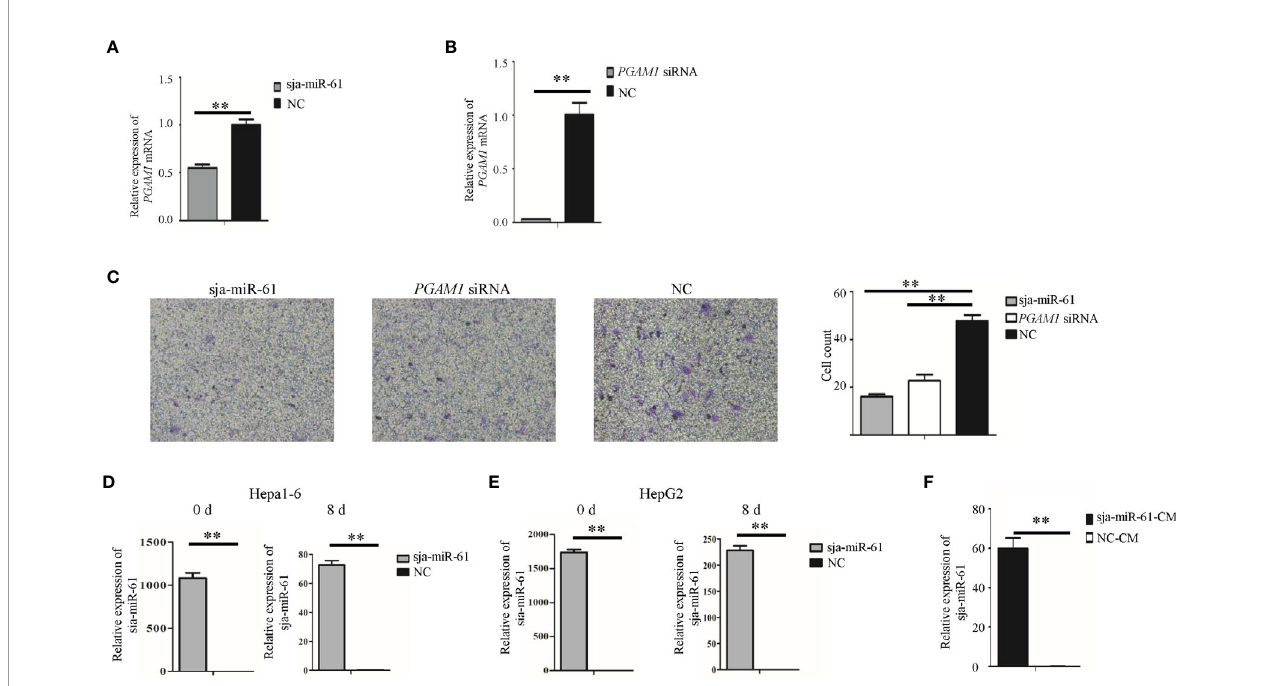
FIGURE 7 | Sja-miR-61-mediated inhibition of migration and tube formation of HUVEC cells by down-regulating PGAM1 in vitro . (A, B) HUVEC cells were transfected with sja-miR-61 mimics and NC mimics (A) , PGAM1 siRNA and NC siRNA (B) , respectively, and 48 h later, the expression of PGAM1 was determined using qRT-PCR. Cell migration was evaluated using transwell inserts without matrigel coating (C) . (D, E) The sja-miR-61 mimics within the transfected cells were measured by qRT-PCR at day 0 (i.e. before inoculation) and 8 post inoculation, using U6 as the internal control, (D) for Hepa1-6 cells, (E) for HepG2 cells. (F) The sja-miR-61 mimics were detected by qRT-PCR in HUVEC cells cultured with conditioned medium (CM) derived from the cultivation of HepG2 cells transfected with sja-miR-61 mimics or NC mimics. Mean ± SD, n = 3, **p <